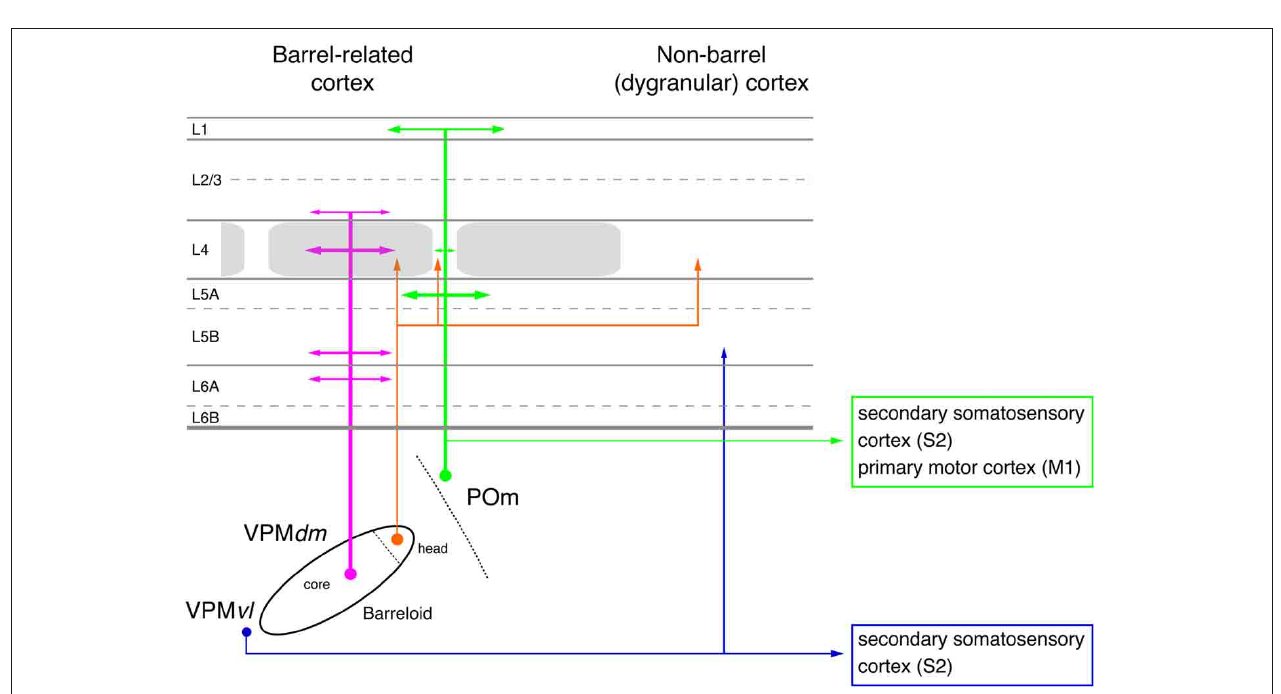
illustrating afferent sparse zones of low fluorescence (i.e., low thalamocortical innervation). There is potential overlay of VPM and POm afferents in the deeper portion of barrels (yellow). Modified from Wimmer et al. (2010), with permission of the Society for Neuroscience.